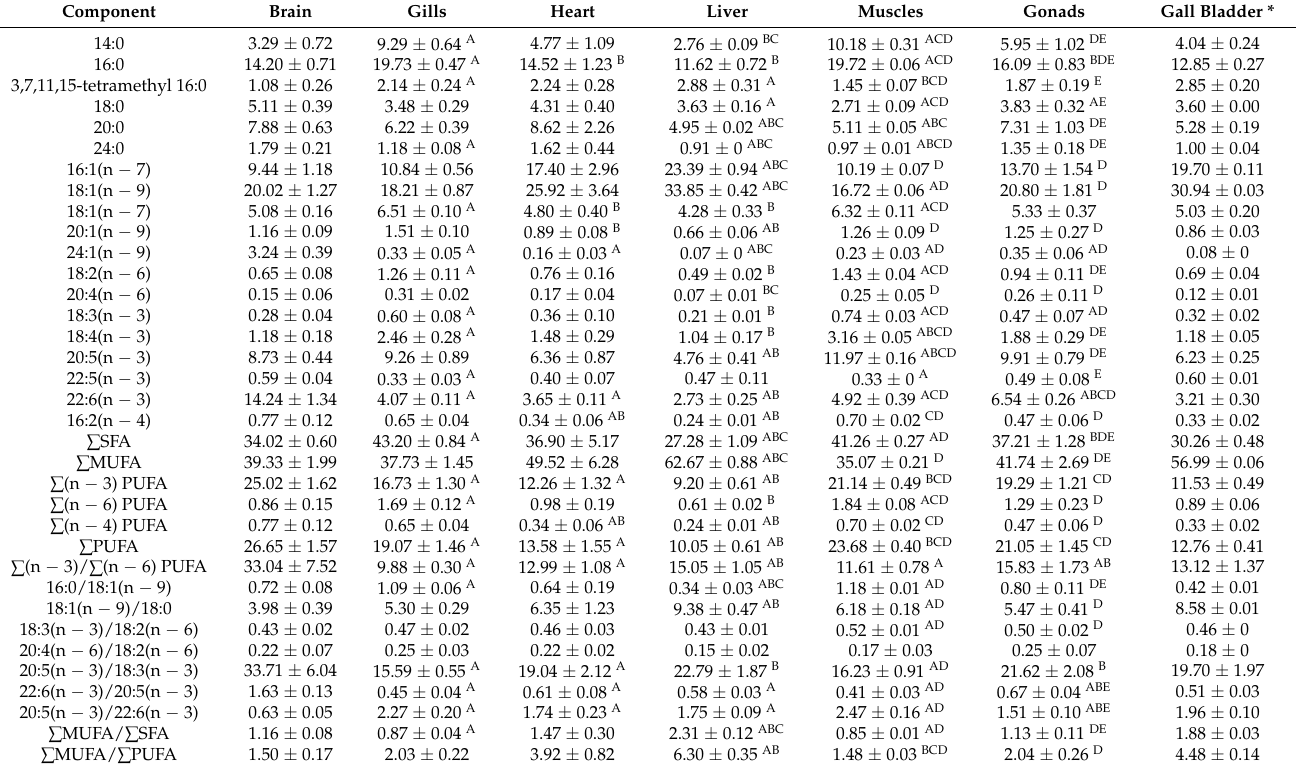
Table 1. The content of fatty acids (% of total fatty acids) in different tissues of adult Antarctic silverfish Pleuragramma antarcticum from the Antarctic Sound, January